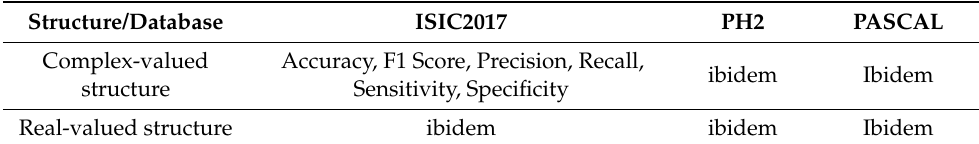
Table 3. Experiment design for this research